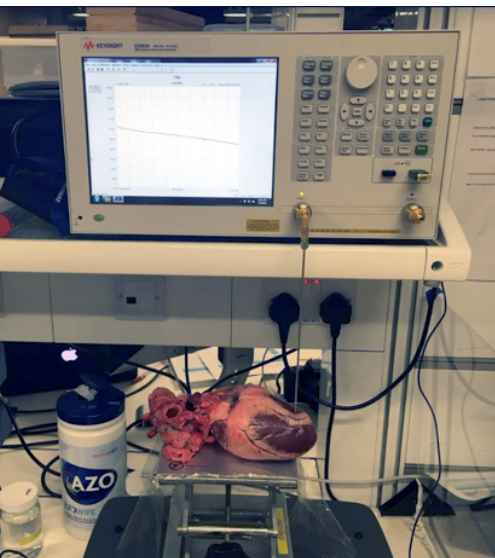
Figure 1. Measurement setup showing VNA2 directly connected to the slim form probe. The sam- ple is brought in contact with the probe by lifting the table while making sure we do not apply excessive probe-sample pressure. The exclusion of the cable from the setup eliminates one source of measurement